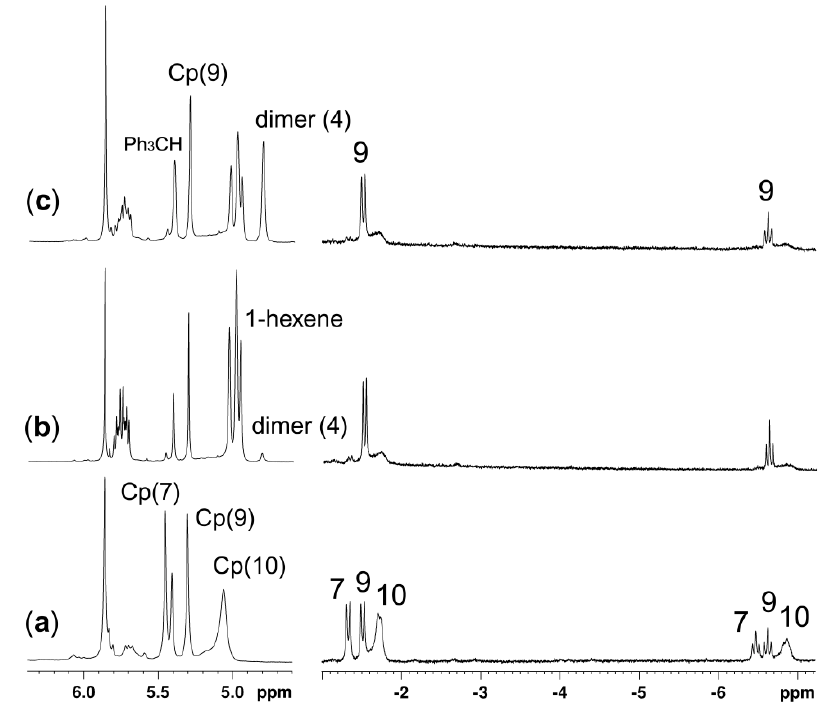
Figure 4. NMR monitoring of the reaction of complexes 7 , 9 , and 10 with 1-hexene in d 6 -benzene (intensity of upfield signals is increased): ( a ) [Cp 2 ZrH 2 ] 2 -ClAlEt 2 -(Ph 3 C)[B(PhF 5 ) 4 ] system, [Zr]:[Al]:[B] = 1:3:0.5; ( b ) [Zr]:[Al]:[B]:[1-alkene] = 1:3:0.5:3.5, 5 min; and ( c ) [Zr]:[Al]:[B]:[1-alkene] =